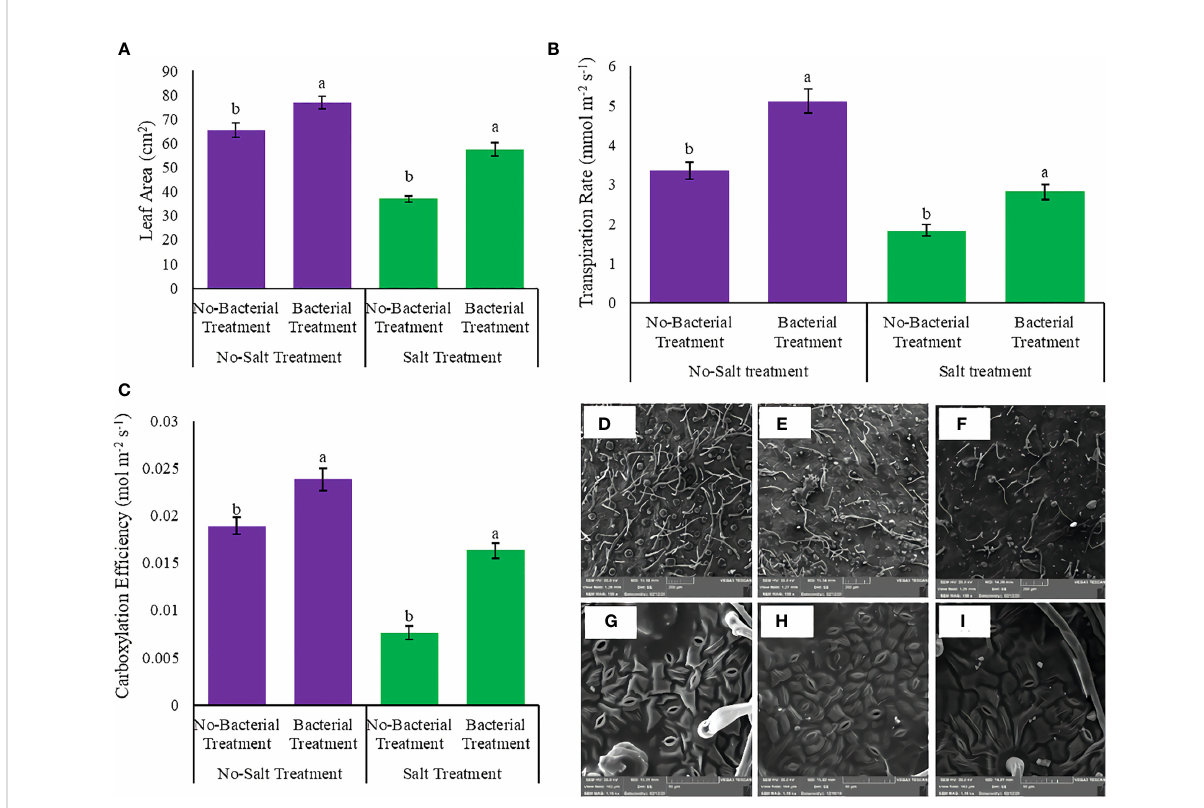
FIGURE 5 Measured parameters variation under studied treatments. (A) Leaf area, (B) Transpiration rate, (C) Carboxylation ef fi ciency, (D) Trichome density under salinity stress (E) Trichome density under integrated salinity and bacterial inoculation, (F) Trichome density under bacterial inoculation. (G) Stomata density under bacterial inoculation, (H) Stomata density under salinity stress integrated bacterial inoculation and (I) Stomata density under salinity stress. According to the analysis of variance, the above present mean comparisons are the only effects that showed signi fi cant difference. Mean values with the same letters are not signi fi cantly different ( p ≤ 0.05), Tukey test. Bars stand for standard error